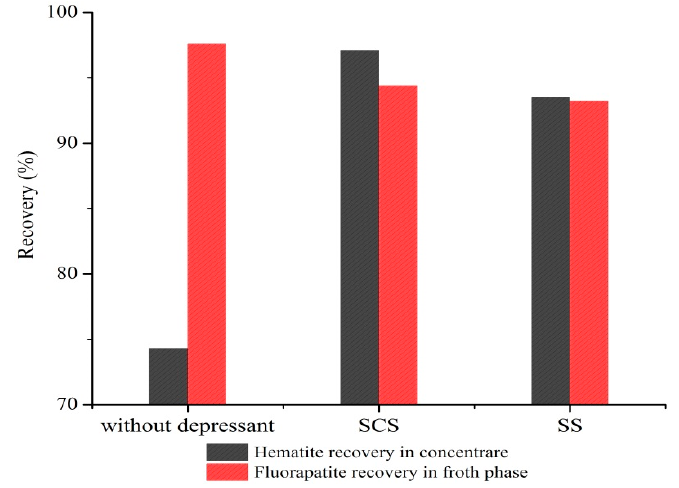
Figure 2. The results of micro-flotation tests on the pure hematite and fluorapatite by using SCS and SS at pH 9.5.